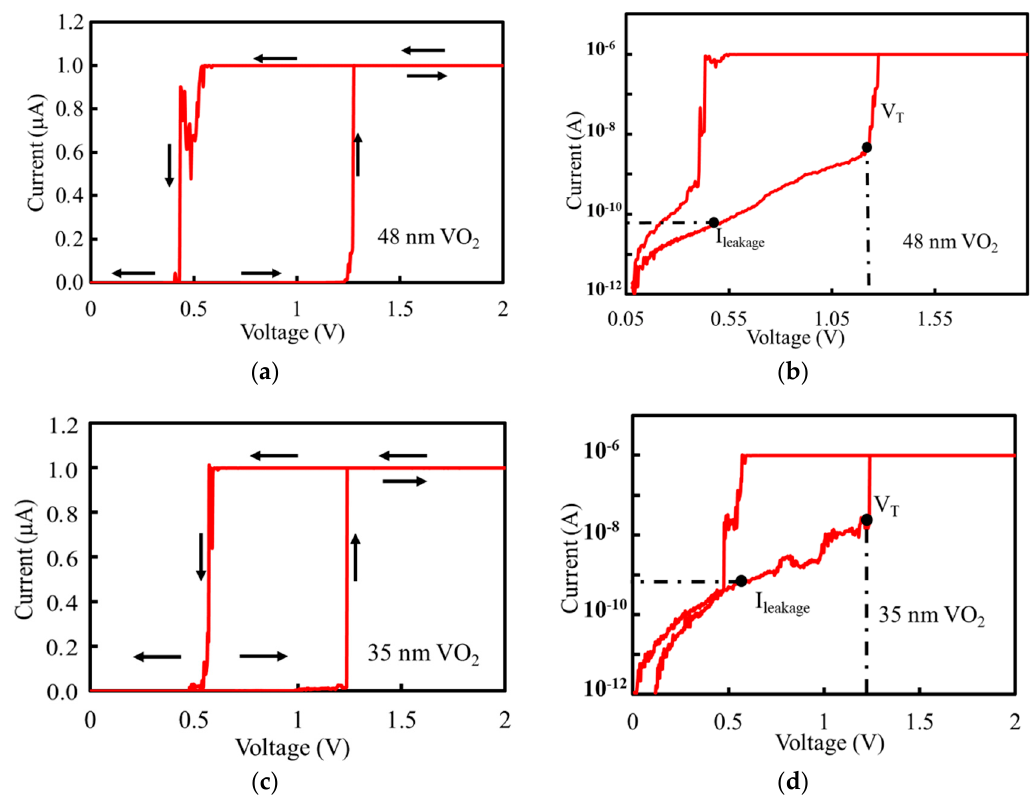
Figure 2. Representative current versus voltage (I-V) measurement results between the Pt AFM probe tip and NP-VO 2 on gold. ( a ) I-V of a 48 nm VO 2 particle and ( b ) the same I-V in log scale clearly showing V T and I leakage at V T /2. ( c ) I-V of a 35 nm VO 2 particle and ( d ) its log scale.